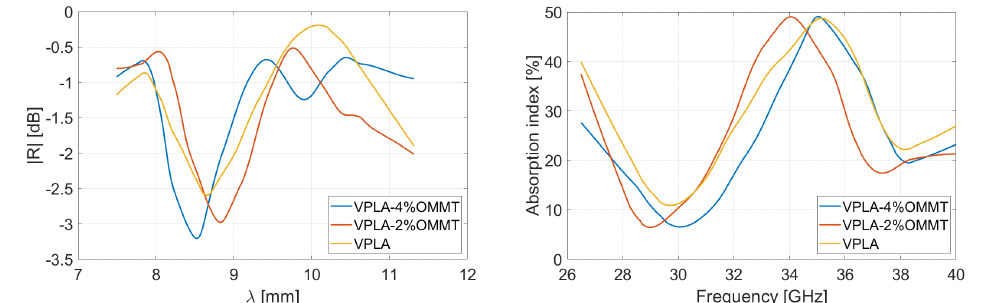
Figure 7. Measurement in Rozanov configuration of reflectivity versus wavelength and absorption versus frequency of virgin PLA films having various wt.% concentration in OMMT. Thickness of films is 400 µm.